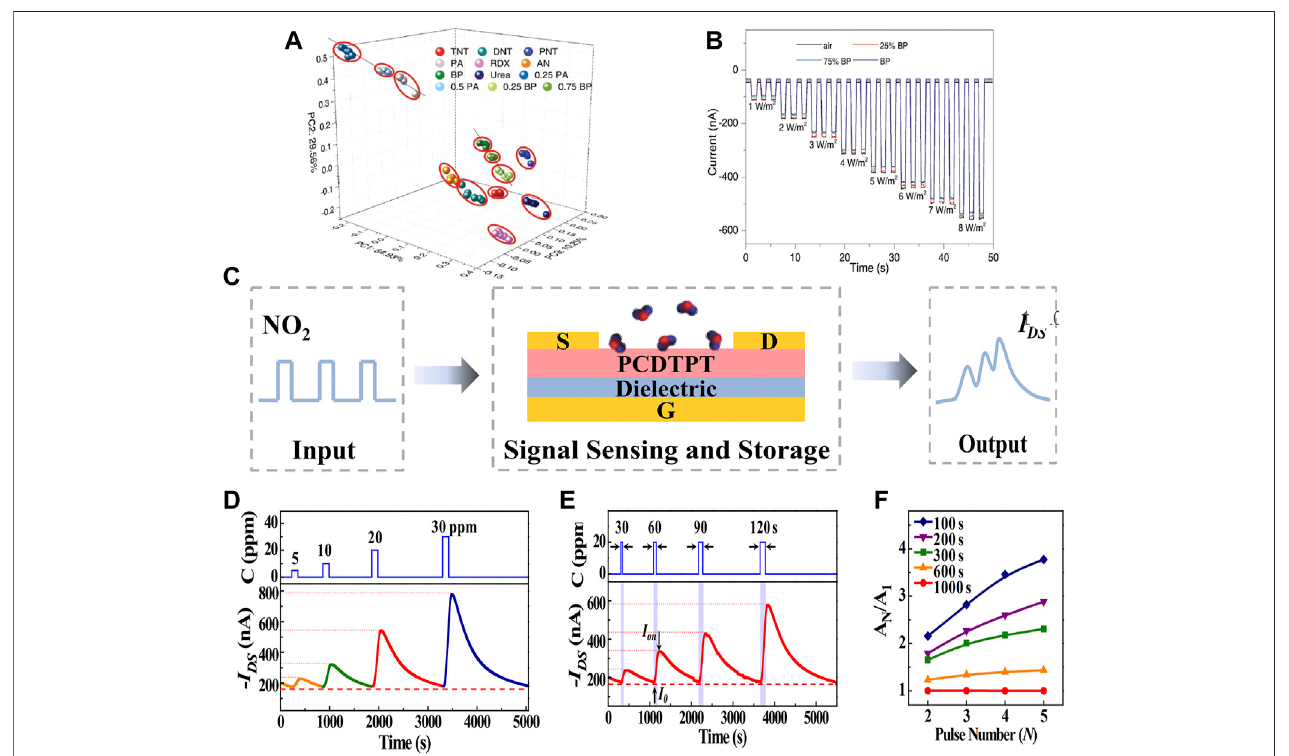
FIGURE 10 | (A) Principal component analysis diagrams of 8 kinds of normal temperature saturated explosive vapors. (B) The time-dependent photo response of the Schottky sensor in different concentrations of BP gas was measured (adapted from Guo et al., 2017). (C) Schematic diagram of the operation model of the arti fi cial organinjurymemorysystemofasinglePCDTPTOFET. (D) TheeffectofNO 2 concentrationfrom5to30ppmonI DS . Δ ττ =120s. (E) In fl uenceof20ppmNO 2 pulsewidth from 30 to 120s on I DS . (F) Gain A N /A 1 as a function of pulse number N at different pulse intervals (adapted from Song et al.,